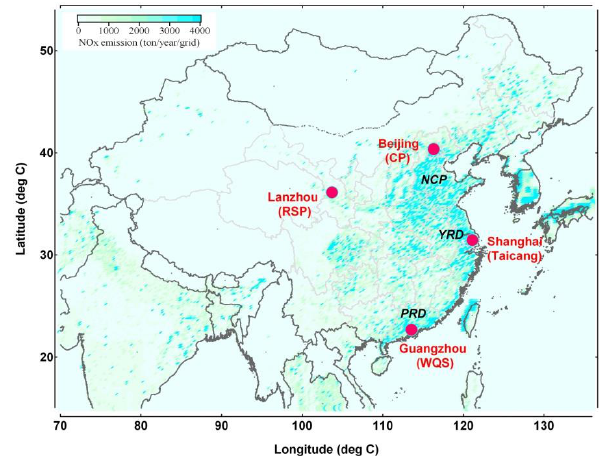
Figure 1. Map showing the study areas and anthropogenic NO x Fig. 1 emissions over China. The emission data were obtained from Q. Zhang et al.